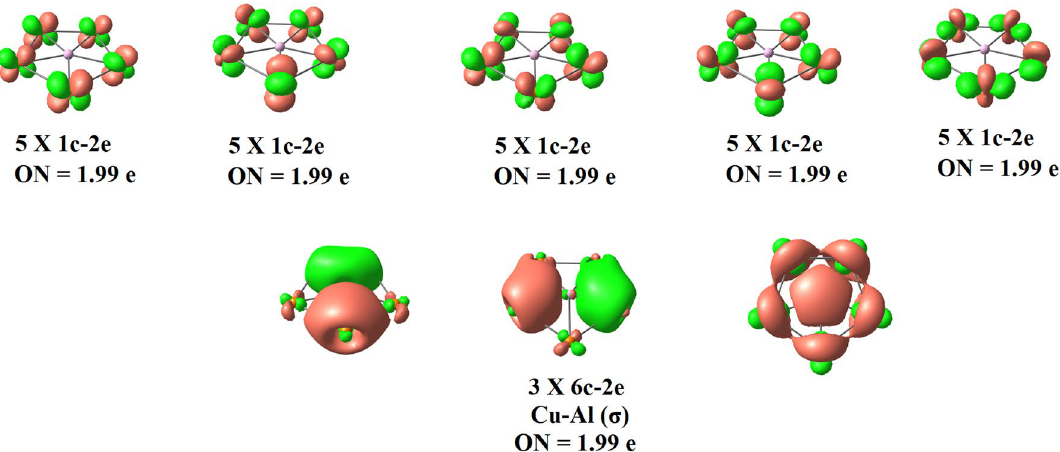
Figure 3. Bonds recovered using AdNDP analysis of Cu 5 Al 2+ cluster.